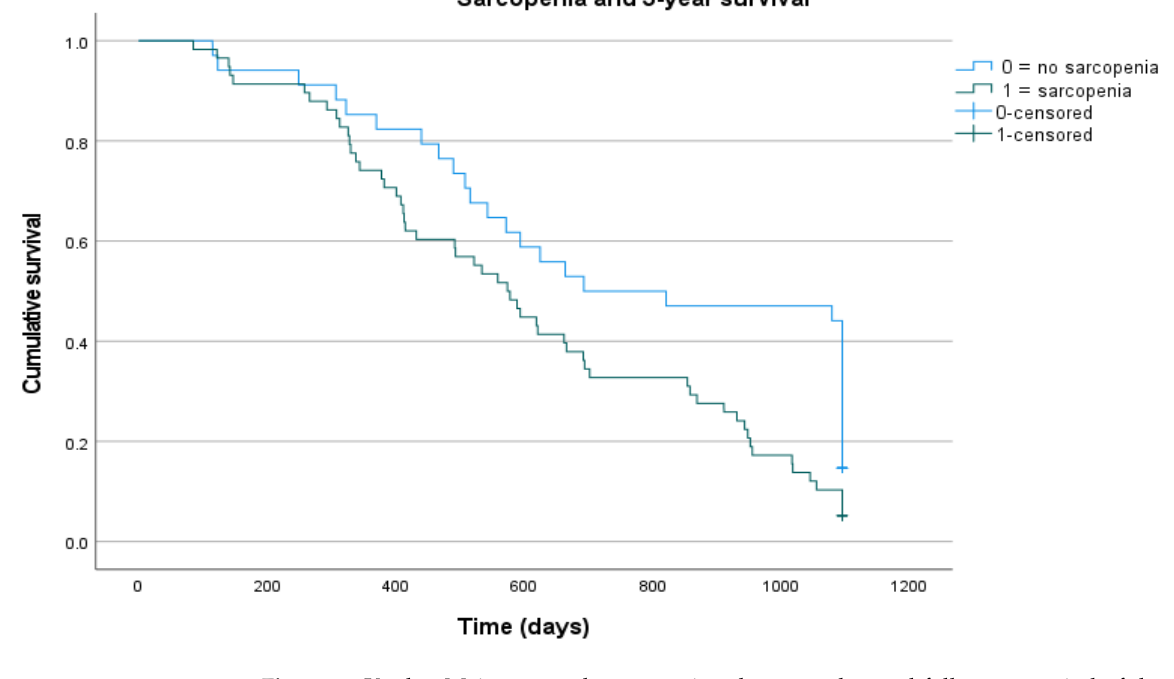
Table 5. Different effects of AI-based body composition parameters on 3-year survival in patients undergoing surgical treatment and in patients undergoing nonsurgical treatment.